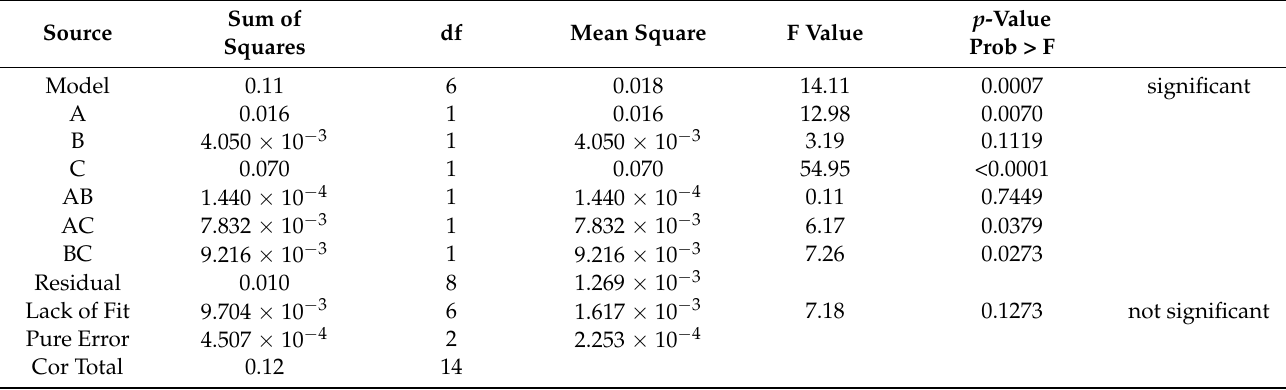
Table 8. ANOVA for response surface two factor interaction